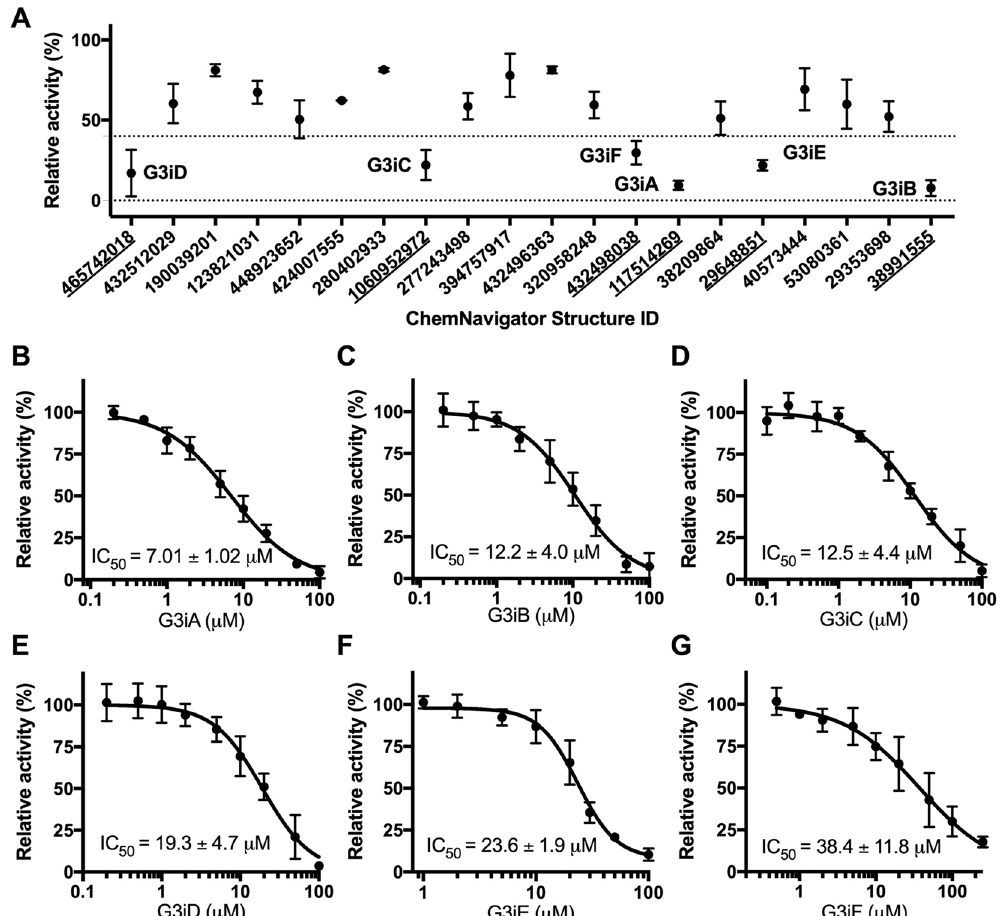
Figure 2. Effect of compounds identified from TBVS on GLUT3 transport activity. (A) GLUT3 relative transport activity in the presence of 50 µM compound concentration, at 3 mM glucose concentration. Glucose transport activity of GLUT3 expressed in hxt 0 yeast cells EBY.S7 was measured as C 14 -glucose uptake in whole cells (see “Materials and methods” for details). The compounds are identified by the ChemNavigator Structure ID. Six compounds, G3iA–G3iF (ChemNavigator Structure ID number underlined), inhibited GLUT3 relative activity by more than 60%. Initial screening at 100 µM concentration for all 193 tested compounds (listed in Supplementary Table S1) is shown in Supplementary Fig. S2. (B–G) Dose response curves for G3iA-G3iF inhibition of GLUT3 relative transport activity. Standard deviations for experimental points come from at least three independent measurements. Graphs, data analysis, and IC 50 values were generated with GraphPad (https:// www. graph pad.